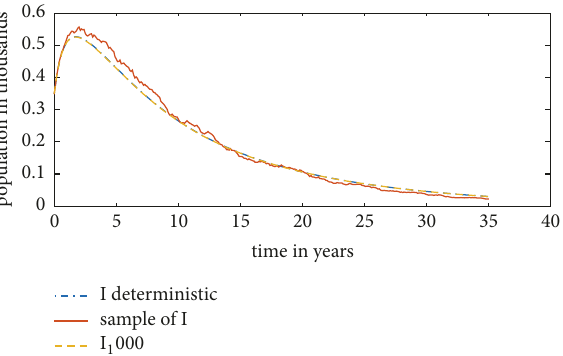
In Figure 3, a choice of 𝑐 1 = 0.000054 and 𝜎 = 0.04 yields 𝑅 0 = 1.1562 and 𝑅 𝜎 = 0.9298. This choice